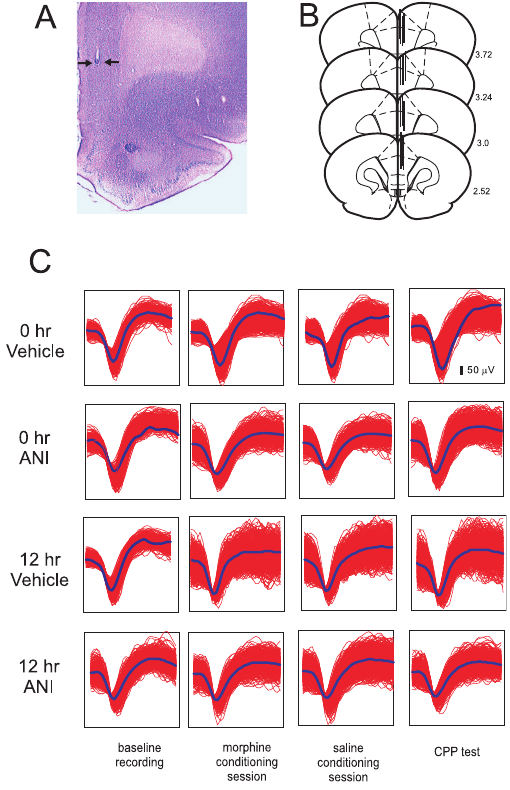
Figure 5. Intra-mPFC microwire recording locations, waveform analysis and effects of intra-BLA ANI on neuronal encoding of opiate reward memory. A , Microphotograph showing a representa- tive intra-mPFC recording wire placement (black arrows). B , Schematic representation of sample intra-mPFC microwire recording location, demonstrating rostral-caudal distribution within the mPFC. C , Sample mPFC neuronal unit waveforms from single channels, recorded over 3 days (baseline, conditioning day, CPP recall test) from four experimental groups receiving either intra-BLA vehicle ANI or vehicle at 0 or 12 hrs post-conditioning D